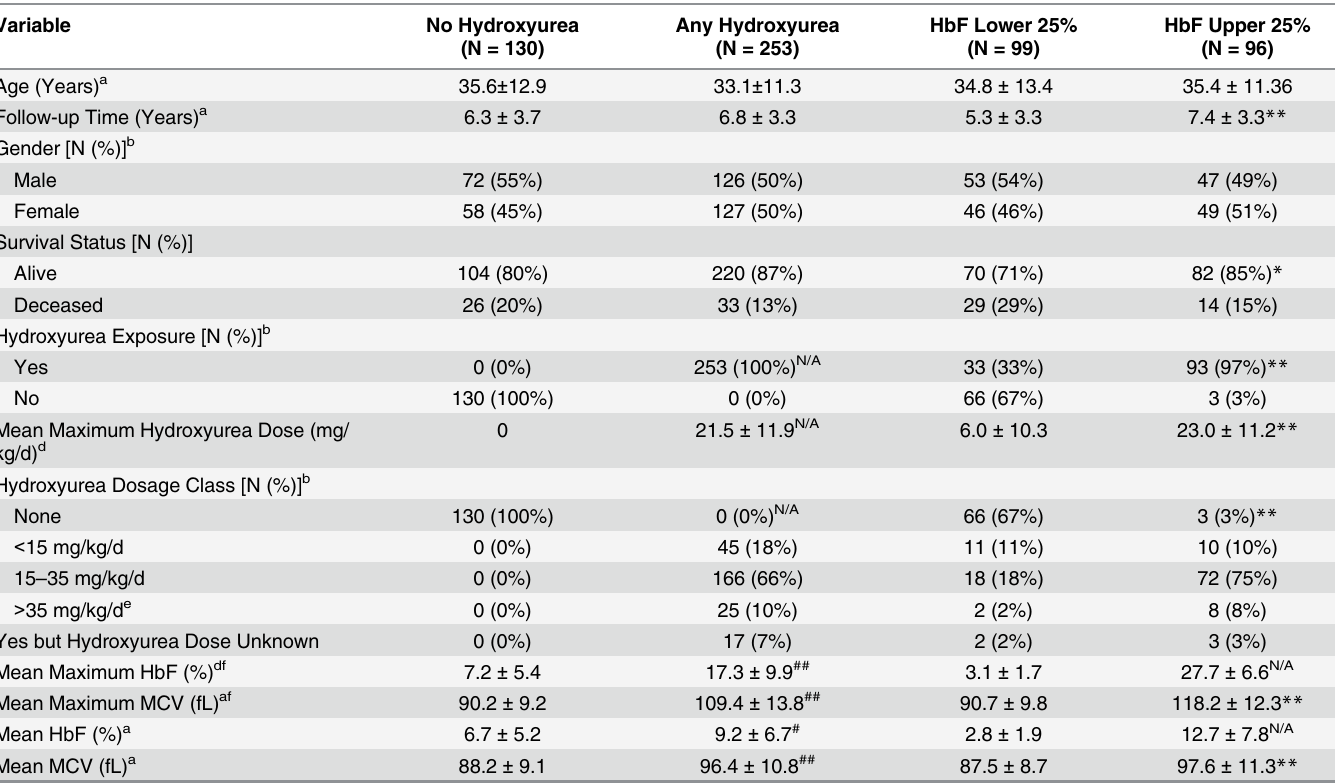
Table 4. Characteristics at Enrollment and Survival Status Based On Hydroxyurea Status and Fetal Hemoglobin Quartiles in Patients with HbSS.